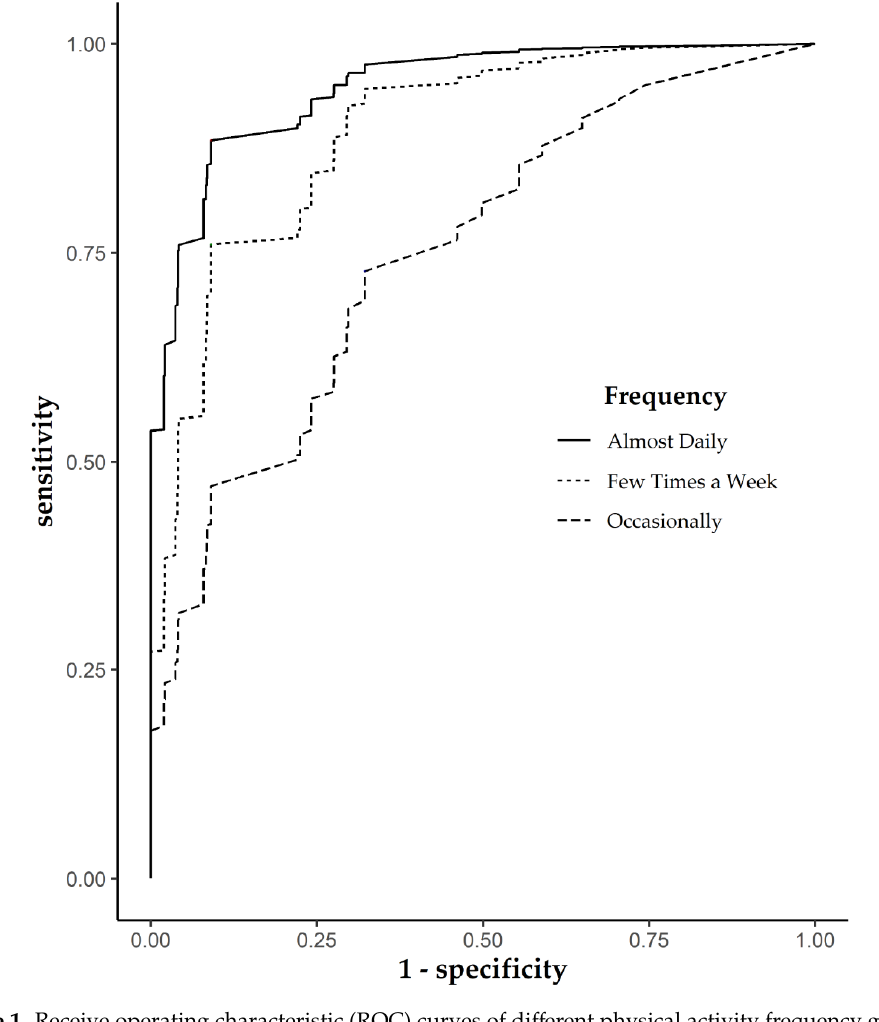
Figure 1. Receive operating characteristic (ROC) curves of different physical activity frequency groups. Never group was the reference.